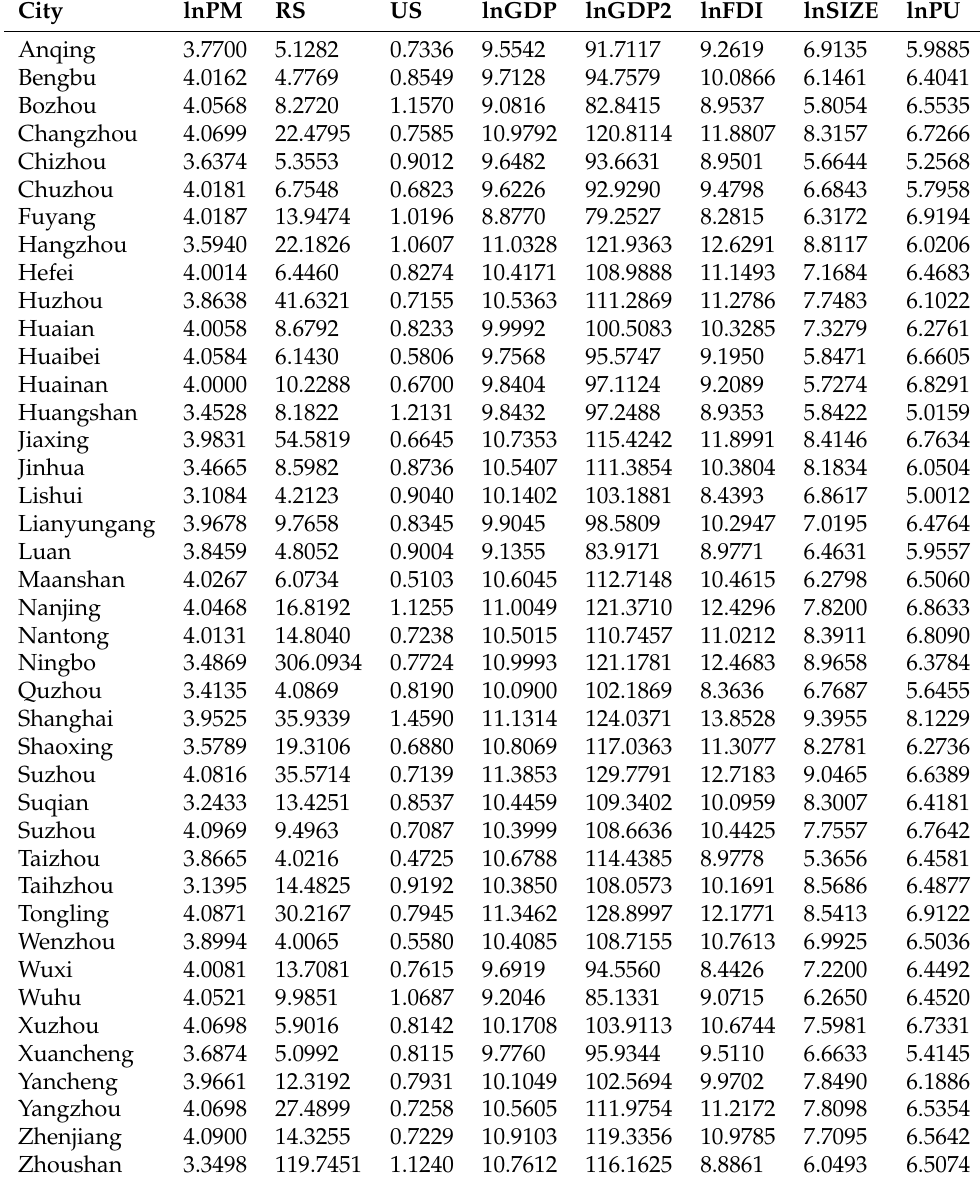
Table 3. Mean value of each city